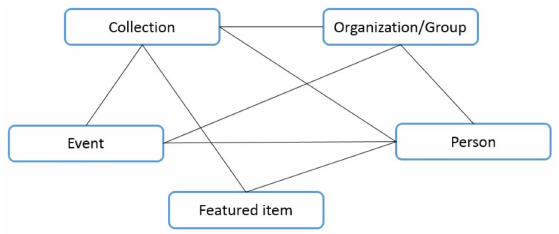
Figure 1. COURAGE